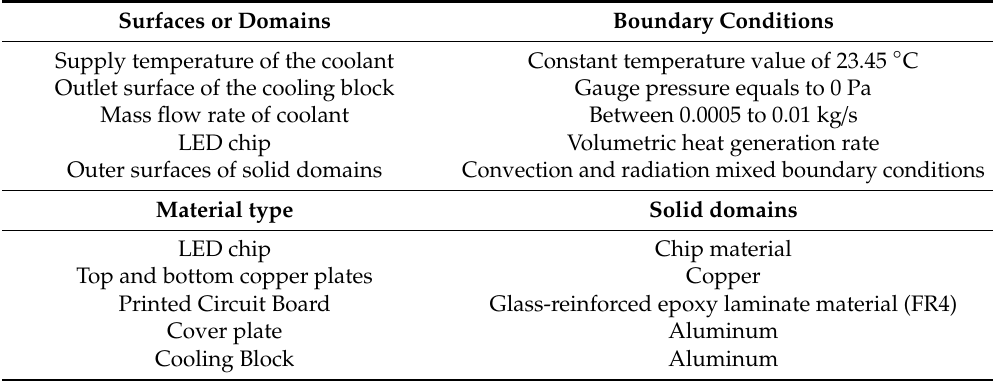
Figure 5. The mesh structure of the LED PCB and cover plate: ( a ) Middle horizontal plane; ( b ) The upper surface mesh. Table 3. Boundary conditions and materials used in the numerical